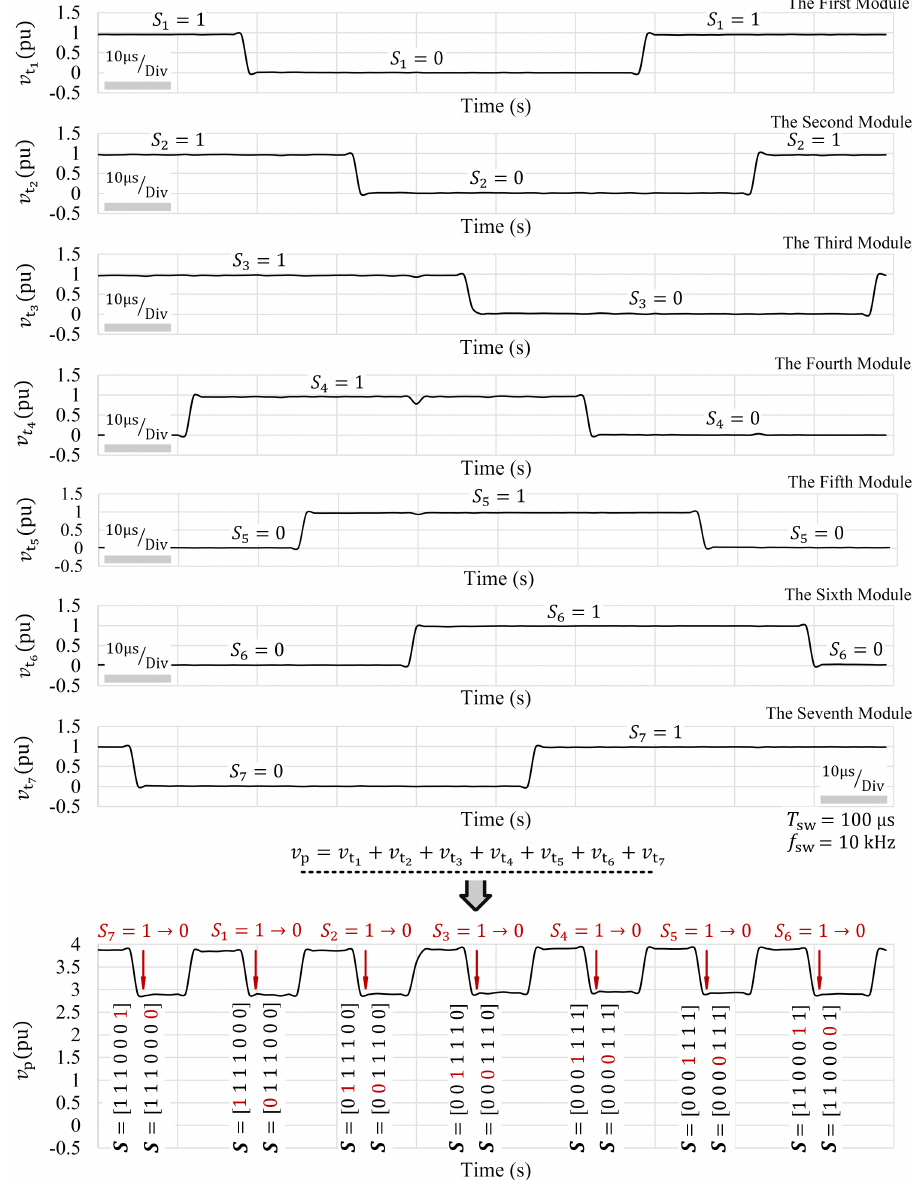
Figure 5. Output voltages of the seven modules and their summation during the decoupling algo-